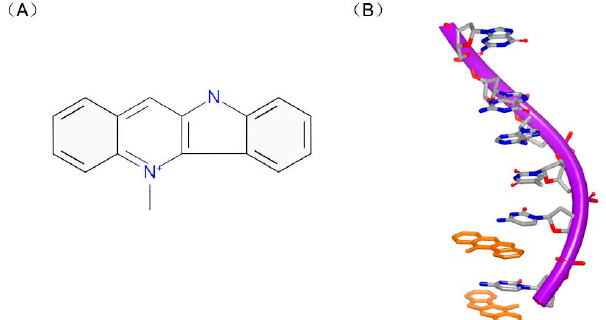
Figure 14. ( A ) Chemical structure of dimer of cryptolepine; and ( B ) one strand of a DNA duplex complex with cryptolepine (PDB code: 1K9G). The orange structure represents the small molecule; the purple structure represents the backbone of nucleic acid; the blue and red atoms in the molecule represent nitrogen and oxygen atoms, respectively.